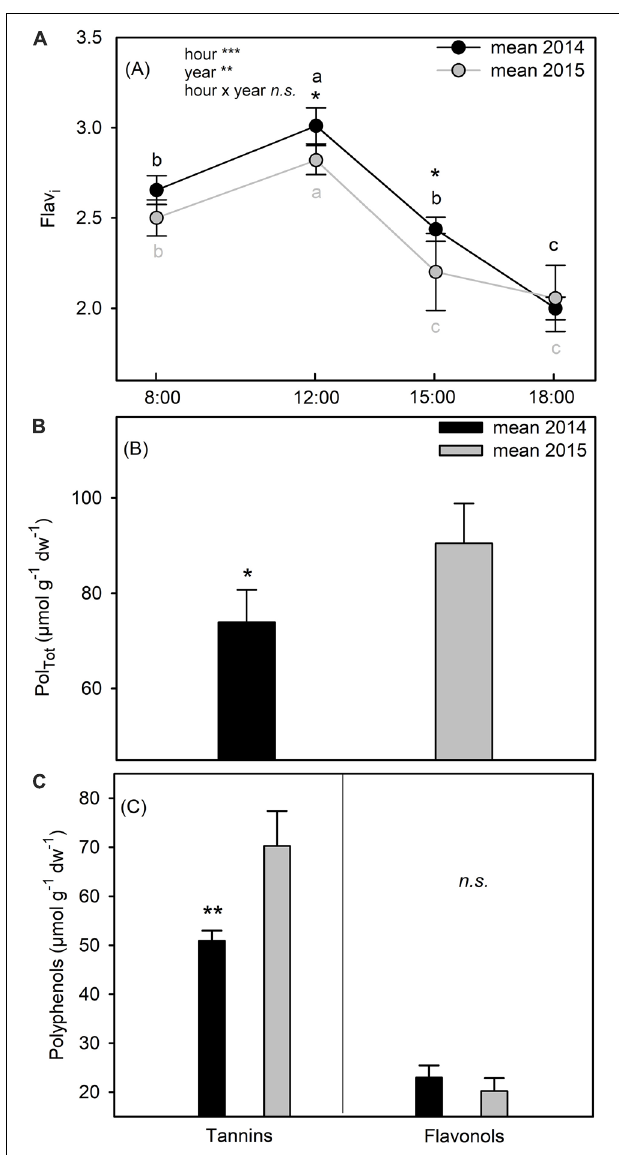
FIGURE 6 | Epidermal Flavonol index (Flav i ) (A) , total polyphenols content (Pol Tot ) (B) , condensed tannins (Tannins) and flavonols leaves content (Flavonols) (C) of C. incanus leaves in July 2014 and 2015. Two way ANOVA followed by Tukey’s pairwise comparison was performed to compare data (means ± SD; n = 8). Letters indicate significant differences ( p ≤ 0.05) among sampling hour for each year, whereas asterisks represent significant differences among years for each sampling hour, *( p ≤ 0.05), **( p ≤ 0.01), ***( p ≤